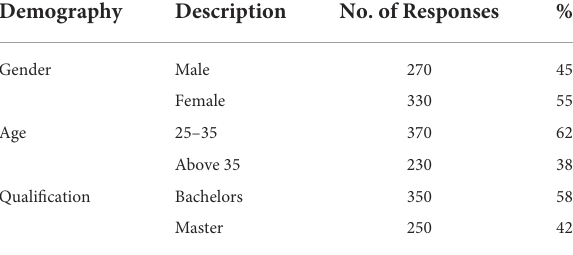
TABLE 1 Demographic profile.